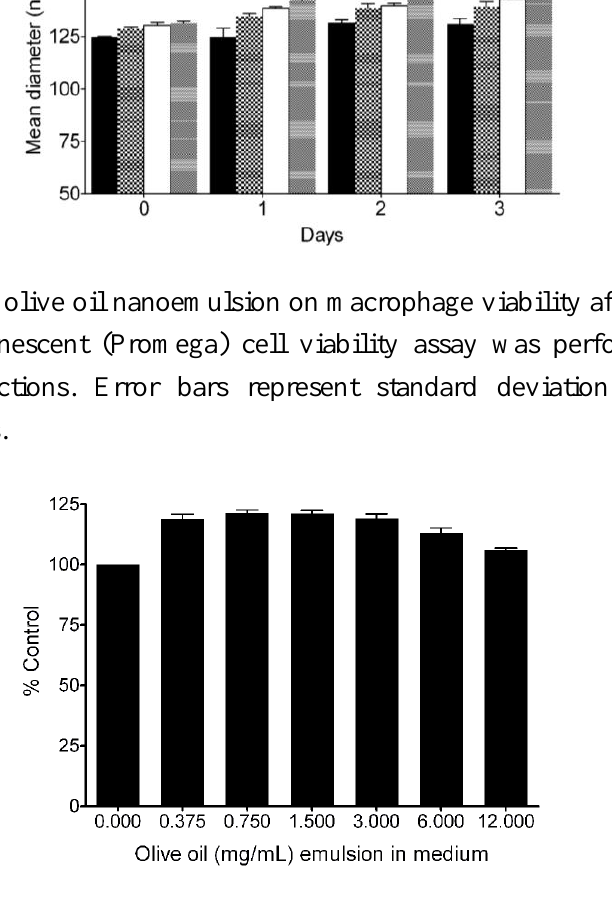
Table S1. Nanoemulsion droplet diameter (nm) and PDI before and after incubation in medium (with/without cells) at 37 °C and 5% CO